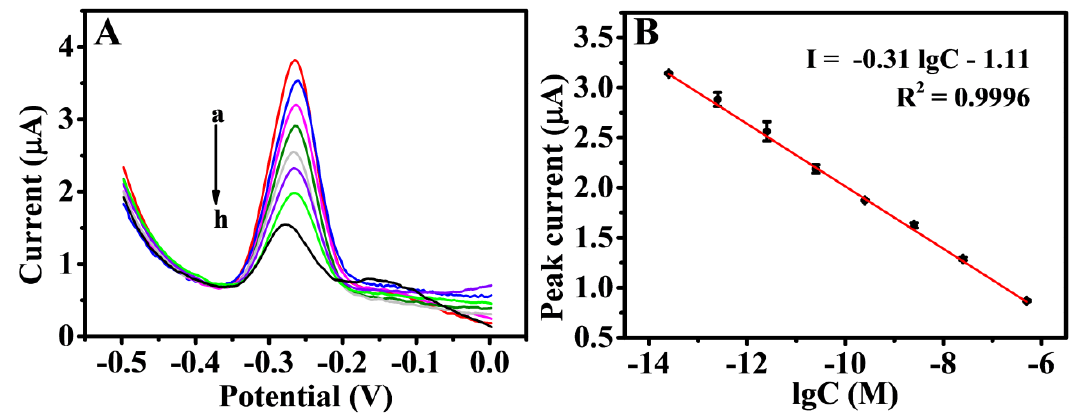
Figure 7. SWV responses ( A ) for various concentrations of T-DNA: 25 fM (a), 250 fM (b), 2.5 pM (c), 25 pM (d), 250 pM (e),